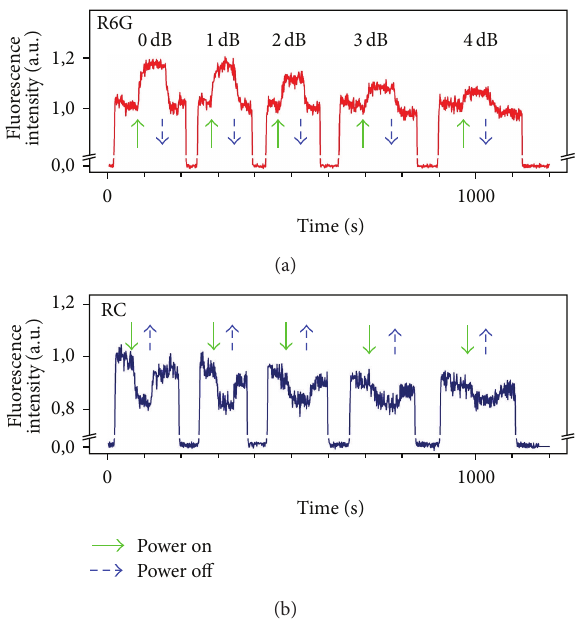
Figure 5: Dynamics of the change in fluorescence intensity when millimeter wave radiation is turned on and turned off. The voltage is switched off and the fluorescence returns to the base line before a different voltage is applied to the microheater. The two curves illustrate the repeatability of the fluorescence to achieve the same level for a given